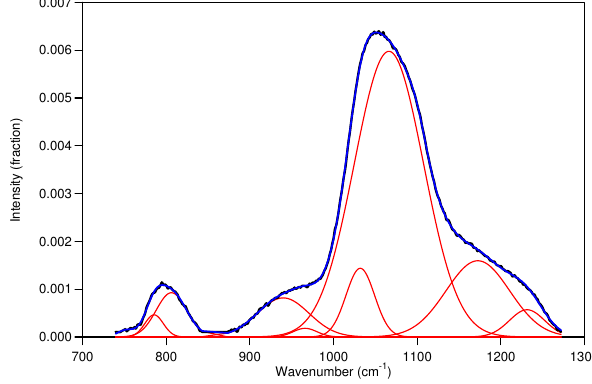
Table 1. Peak information for the BFC mod FTIR spectra in Fig.